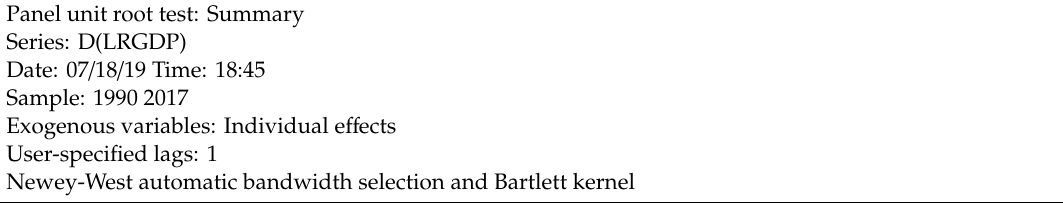
Table A6. Panel Unit Root Test for DLRGDP